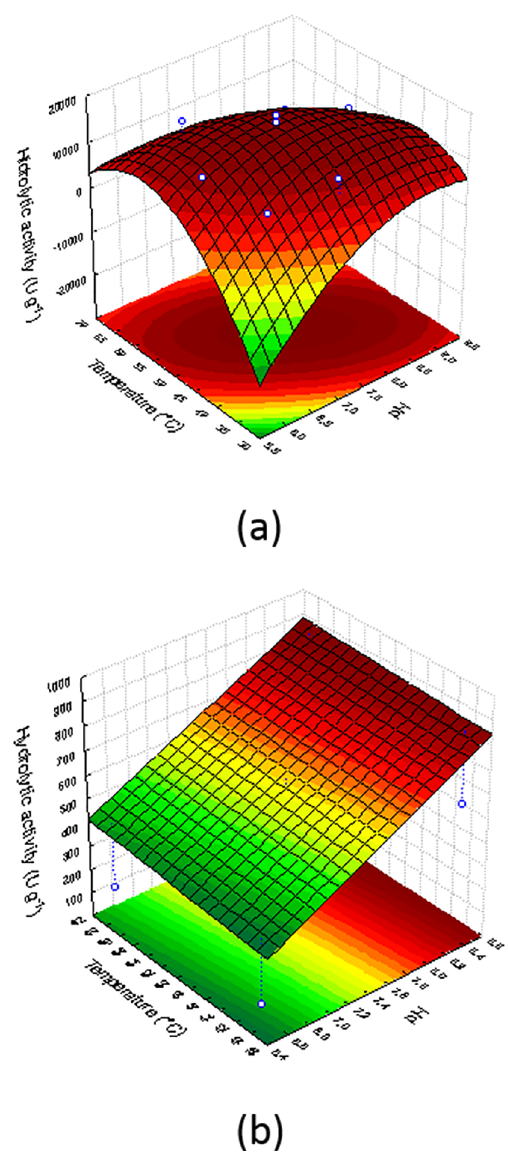
Figure 6. Response surface for: (a) free lipase, (b) lipase immobilized lipase by physical absorption (PA), and (c) lipase immobilized by covalent attachment